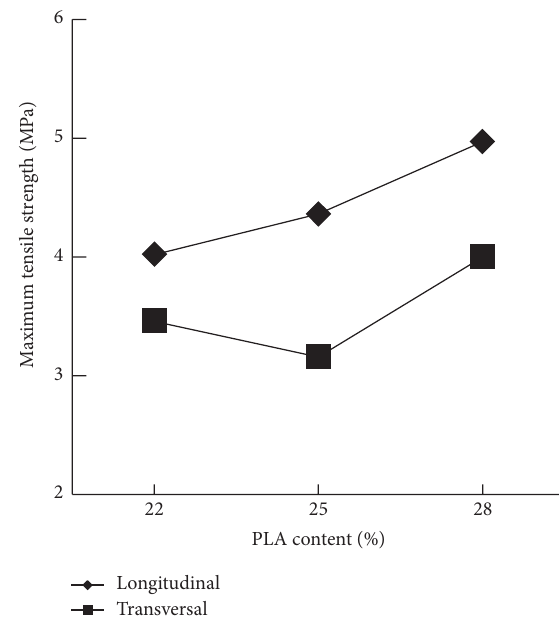
Figure 1: Behavior of maximum tensile strength against polylactic acid